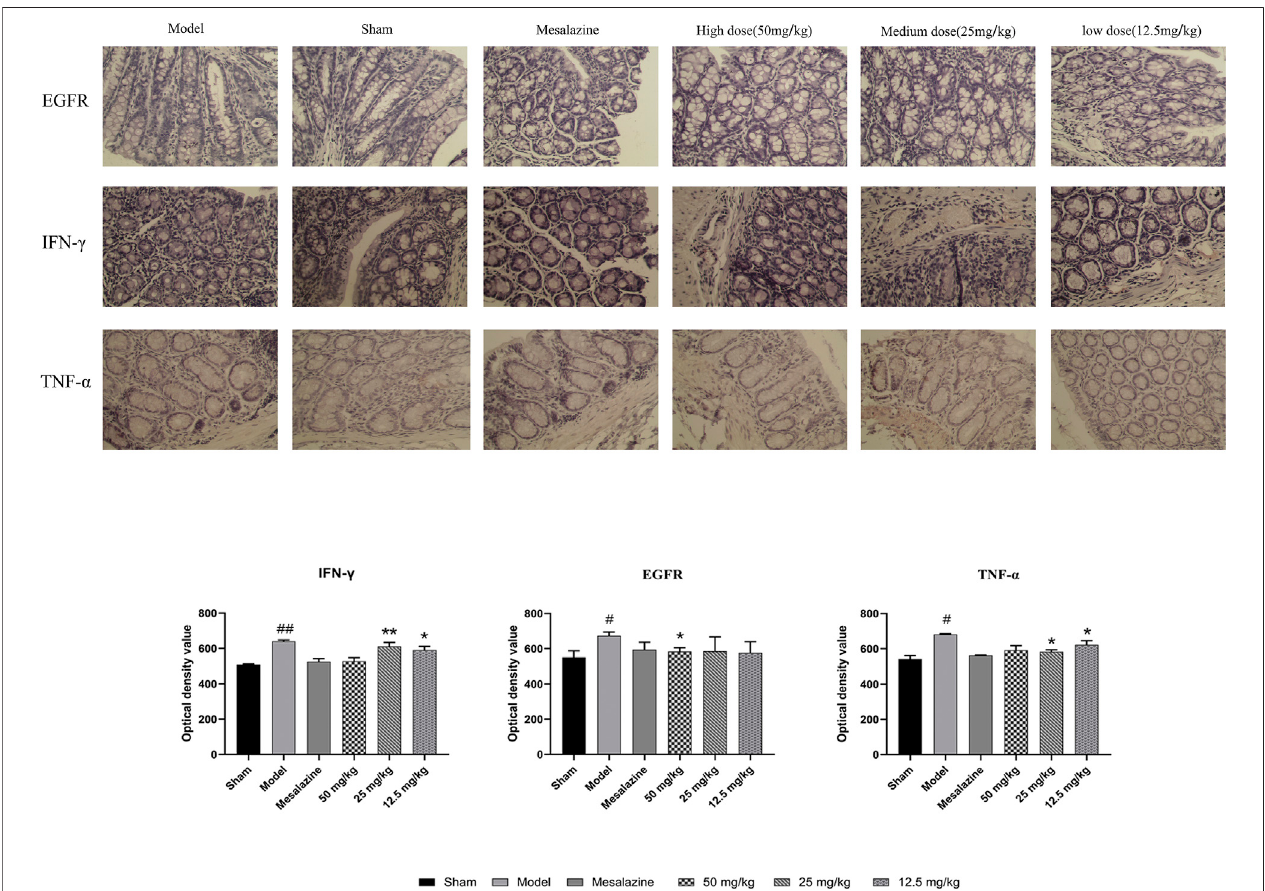
FIGURE8| Effects oflavender essentialoilonpathologicalchangesandexpression ofEGFR,IFN- γ ,and TNF- α incolonic tissueofmodel mouse( × 200). Effectsof lavender essential oil on expression of EGFR, IFN- γ , and TNF- α in colonic tissue of model mouse (Immunohistochemistry). # p < 0.05 vs. control group; * p < 0.05 vs. model group.